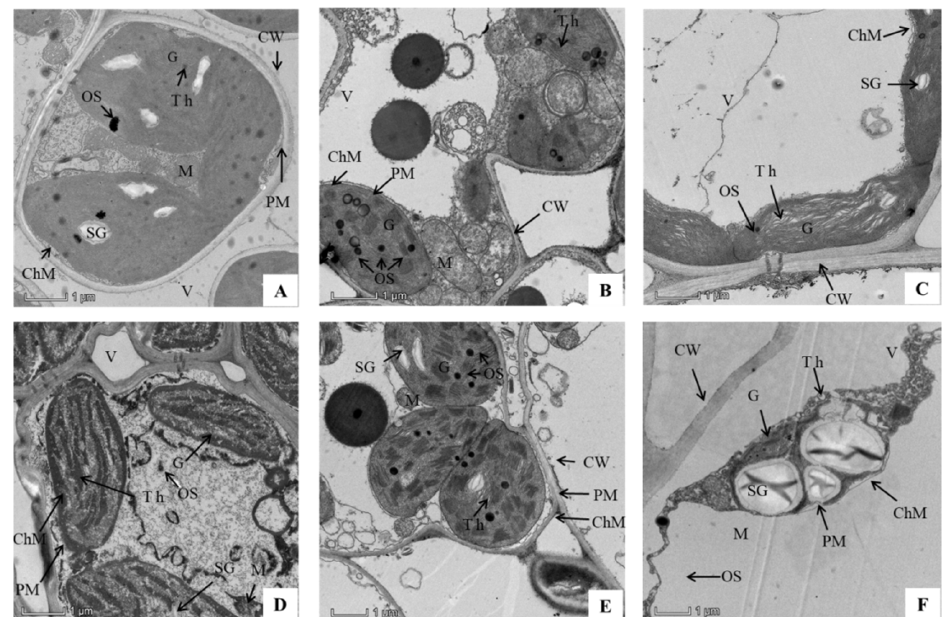
Figure 4. TEM images of the mesophyll cells in rice seedlings ( A ) treated without SAR and P. oryzae (control), ( B ) treated with acid rain at pH 4.0, ( C ) treated with acid rain at pH 2.0, ( D ) inoculated with P. oryzae , ( E ) treated with pH 4.0 and P. oryzae , and ( F ) treated with pH 2.0 and P. oryzae . ChM: chloroplast membrane; CW: cell wall; G: grana; M, mitochondrion; Th: thylakoid; OS: osmium; PM: plasma membrane; SG: starch granule; V: vacuole.